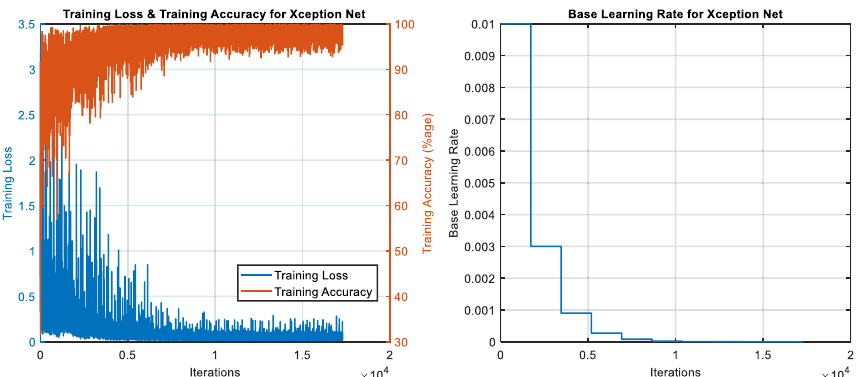
Fig. 10 Plot for training loss, accuracy, and base learning rate for XceptionNet